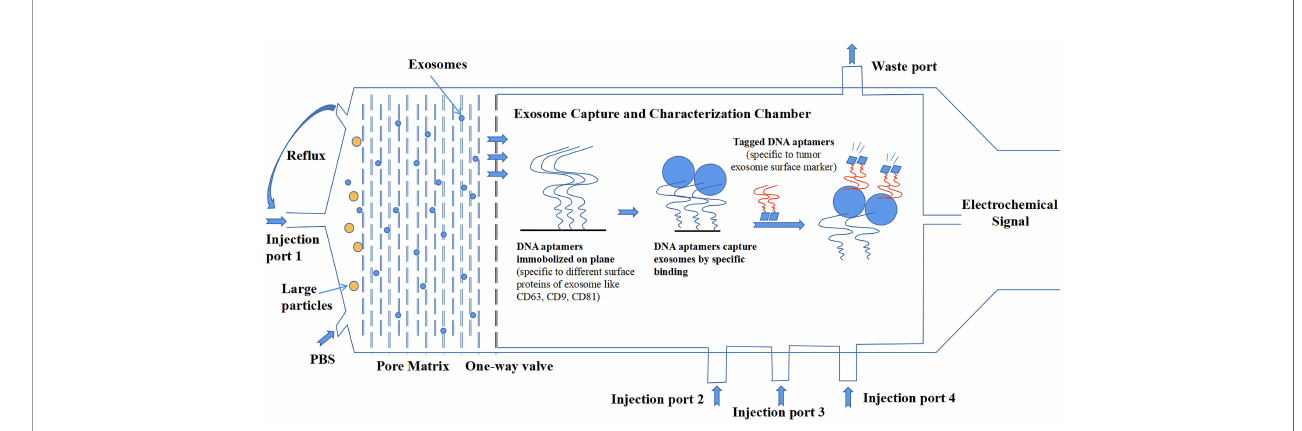
FIGURE 3 | A design of micro fl uidics system for clinical exosome isolation and characterization with high ef fi ciency and high sensitivity. The fi rst module of the system is a pore matrix (pore size ~200 nm). When microliters of plasma/serum is injected through the injection port 1, pressure will be added to the module, which makes particles inside the sample move toward the pore matrix. Nanoparticles including exosomes will move through pore matrix, while large particles will be left in the chamber. Then, phosphate-buffered saline (PBS) solution is injected into the chamber to create re fl ux to wash the pore matrix to ensure all exosomes move across the matrix and reach the one-way valve. In the second module, exosomes were captured in a characterization chamber. Enough quantities of DNA aptamers that speci fi cally recognize exosome surface proteins like CD63, CD81, and CD9 are immobilized on the plane. Exosomes were captured while fl owing across the plane, and buffer was injected through port 2. Impurities were discharged through the waste port. After that, tagged DNA aptamers that speci fi cally recognize tumor- speci fi c antigens were injected through port 3, and tumor-derived exosomes were bound by those aptamers. Finally, the chemiluminescence reagent was injected through port 4 and reacted with the tagged aptamers. The chemical signal was captured and exported